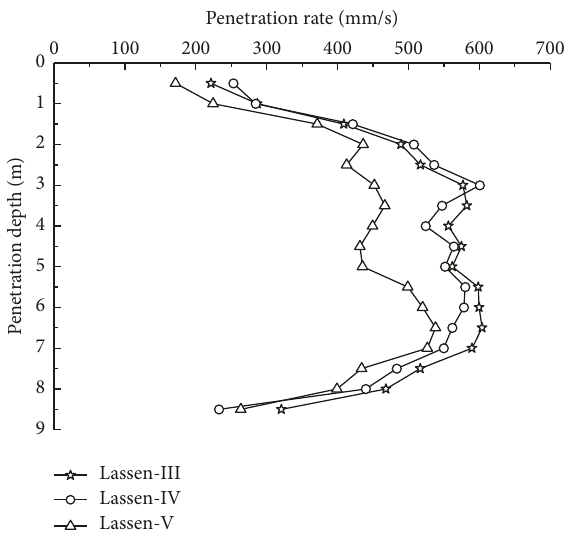
Figure 6: Penetration rate of piles with different types versus penetration depth.